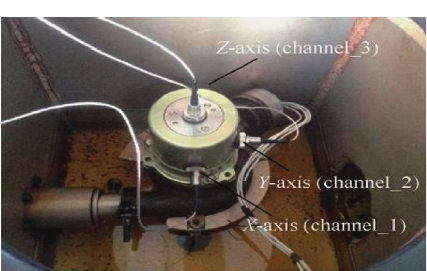
Figure 9: The installation of the airborne fuel pump in the